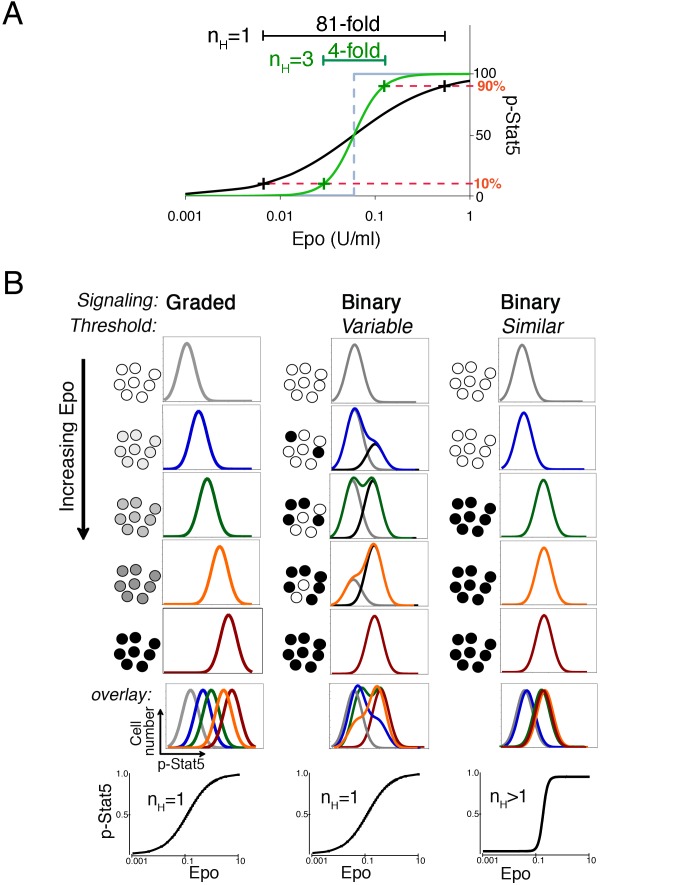
Measurement of binary and graded signaling responses by flow
cytometry.(A) Dose/response curves for graded and binary (switch-like) responses.
The grey line shows an idealized switch response. An infinitesimally
small change in stimulus such as Epo results in an increase of response
from 0% to 100%. The black curve shows a graded response
with nH = 1. An 81-fold increase in
stimulus is required to shift the response from 10% to 90%
of maximum. The green curve shows a steep, switch-like or binary
dose/response curve (nH = 3). Only a
4-fold change in stimulus is required in order to generate a similar
increase in response. (B) Contrasting graded and binary signaling
responses: three hypothetical examples. In a graded signaling response
(left panels), increasing Epo concentration results in a graded increase
in p-Stat5 in individual cells, represented by increasingly darker
shades of grey. Simulations of the corresponding flow-cytometric
profiles show that increasing Epo concentration causes a gradual shift
of the p-Stat5 fluorescence histogram to the right. A plot of the total
p-Stat5 median fluorescence intensity (MFI) versus Epo concentration has
Michaelian kinetics with a Hill coefficient (nH) of 1 (lower
left panel, please note a log scale was used for the
x-axis). In binary signaling (middle and right panels),
the p-Stat5 signal in individual cells can only assume two states,
either “off” (white) or “on” (black), but
intermediate states (shades of grey) are unstable. Two distinct cases of
binary signaling are illustrated that differ in their threshold
responses. In “variable threshold” (middle panels), the
threshold at which Epo causes a cell to switch from “off” to
“on” varies substantially between cells of the population.
Consequently, increasing Epo concentration causes a gradual increase in
the number of cells that are p-Stat5+
(“on”). The simulated flow-cytometric histograms at each Epo
concentration (in color) are each the sum of two histograms,
corresponding to cells that are “off” (light grey
histograms) and cells that are “on” (black histograms). The
median fluorescence of the “on” and “off”
histograms each remain unaffected by Epo concentration, but as Epo
increases, the number of cells in the “on” histogram,
reflected by its height, increases, with a corresponding decrease in the
height of the “off” histogram. Although individual cells
have binary responses, there is a graded increase in the MFI of the
colored histograms representing the whole population. Therefore, a plot
of total p-Stat5 MFI versus Epo concentration shows a graded response
(here, the Hill coefficient is nH = 1).
In the case of cells with binary responses and similar threshold (right
panels), cells switch from “off” to “on” within
a much narrower Epo concentration range. Consequently, the response of
the whole population reflects the response of individual cells more
closely. Flow-cytometric histograms representing the population tend to
be in one of two principal positions, corresponding to the
“on” or to the “off” states. A plot of total
p-Stat5 MFI versus Epo concentration is steep, reflected by a high Hill
coefficient (nH>1).